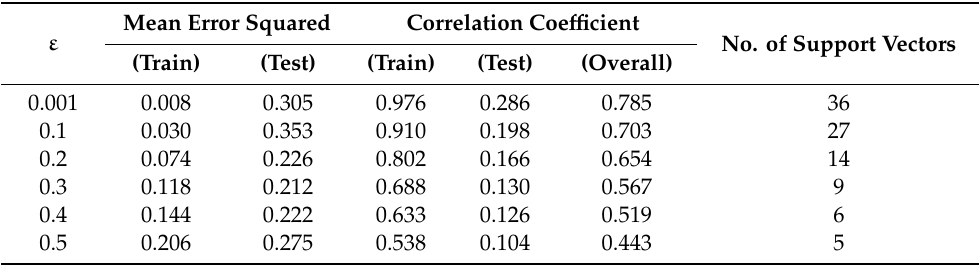
Table 3. The result of various Epsilon parameter ε , of SVM model where C = 8.5 and gamma = 0.2 of total behavior prediction model.